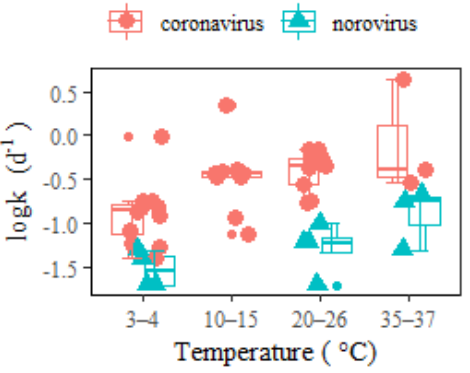
Figure 3. RNA decay rates of coronavirus and norovirus in wastewater at different temperatures. The middle lines inside the box represent median k values. The top and bottom borders of the box represent the 75%ile and 25%ile of k values, respectively. The top and bottom whiskers represent the upper and lower limit of k values in the groups. In addition, the smaller dots represent the outliers.